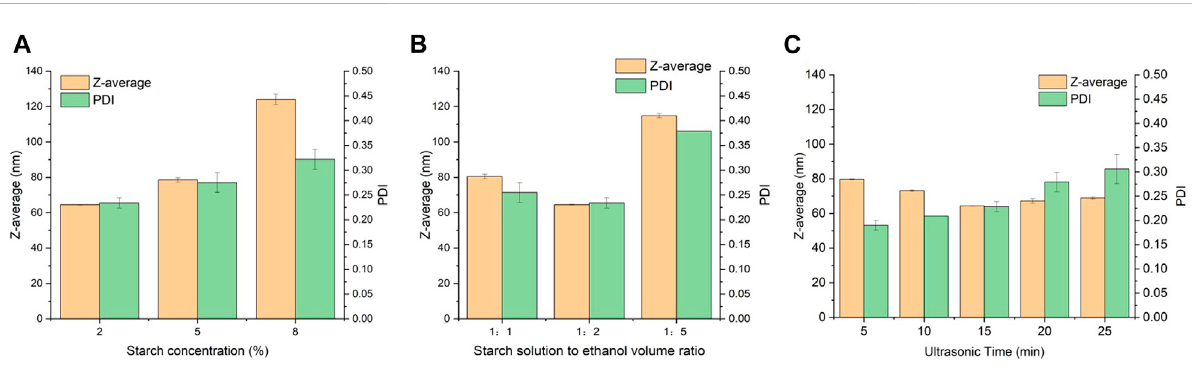
FIGURE 1 Effects of preparation parameters on the particle size of SNPs. (A) Starch concentration. (B) Starch solution to ethanol volume ratio. (C) Ultrasonic